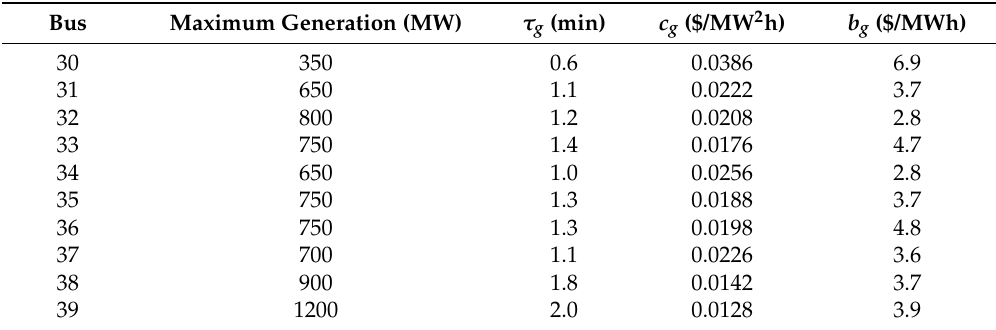
Figure 4. One-line diagram of the IEEE 39 bus network. Table 1. Parameter values for the maximum generation and the dynamic behaviors of 10 suppliers in the IEEE 39 bus network.